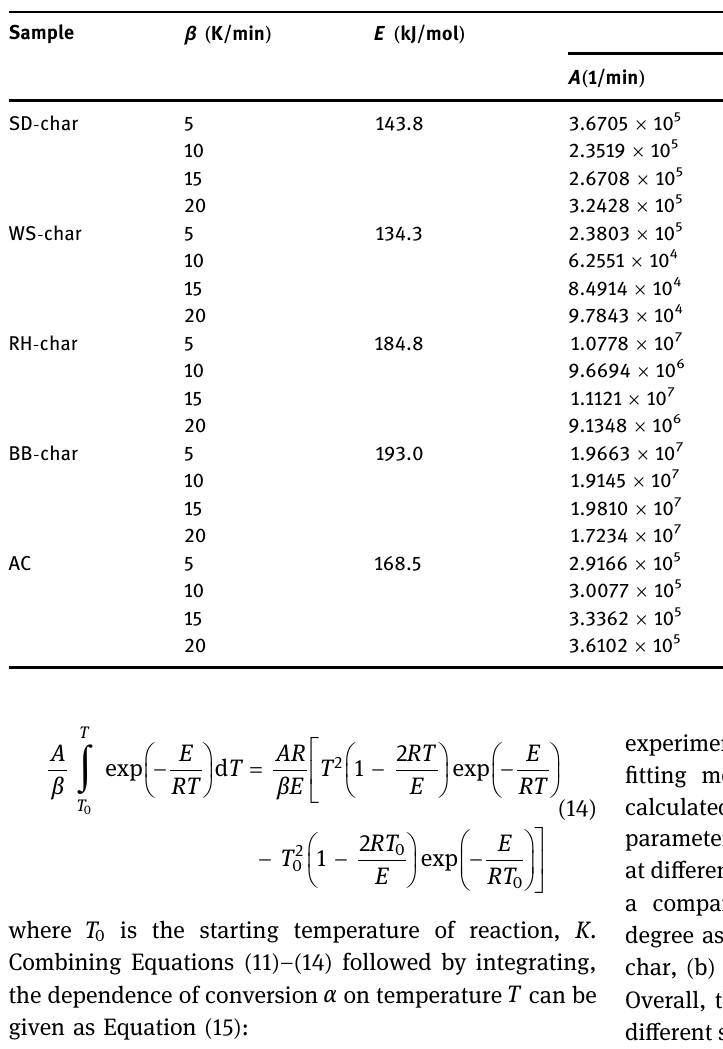
Table 3: Kinetic parameters fi tted to Equation ( 15 ) for the gasi fi cation reaction of di ff erent samples